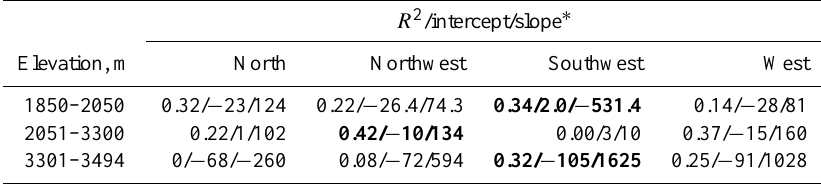
R 2 /intercept/slope ∗